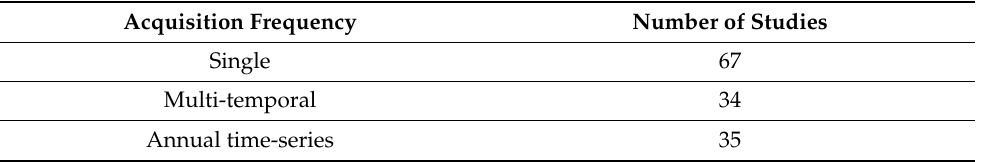
Table 5. Number of studies reviewed according to the acquisition frequency of remote sensing data